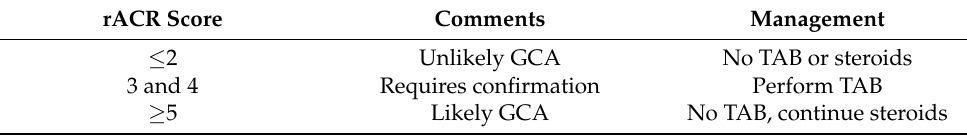
Table 3. Clinical tool for rACR criteria.